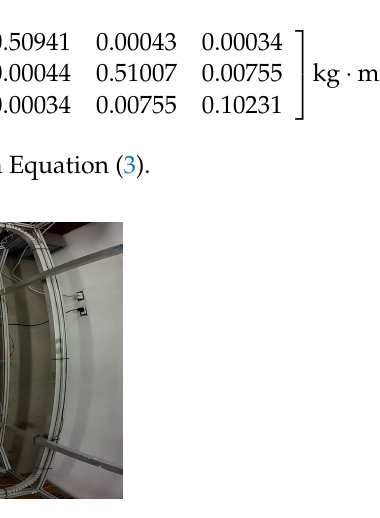
Figure 6. The engineering unit of ABCS integrated to the facility and diagnostic devices (on top).